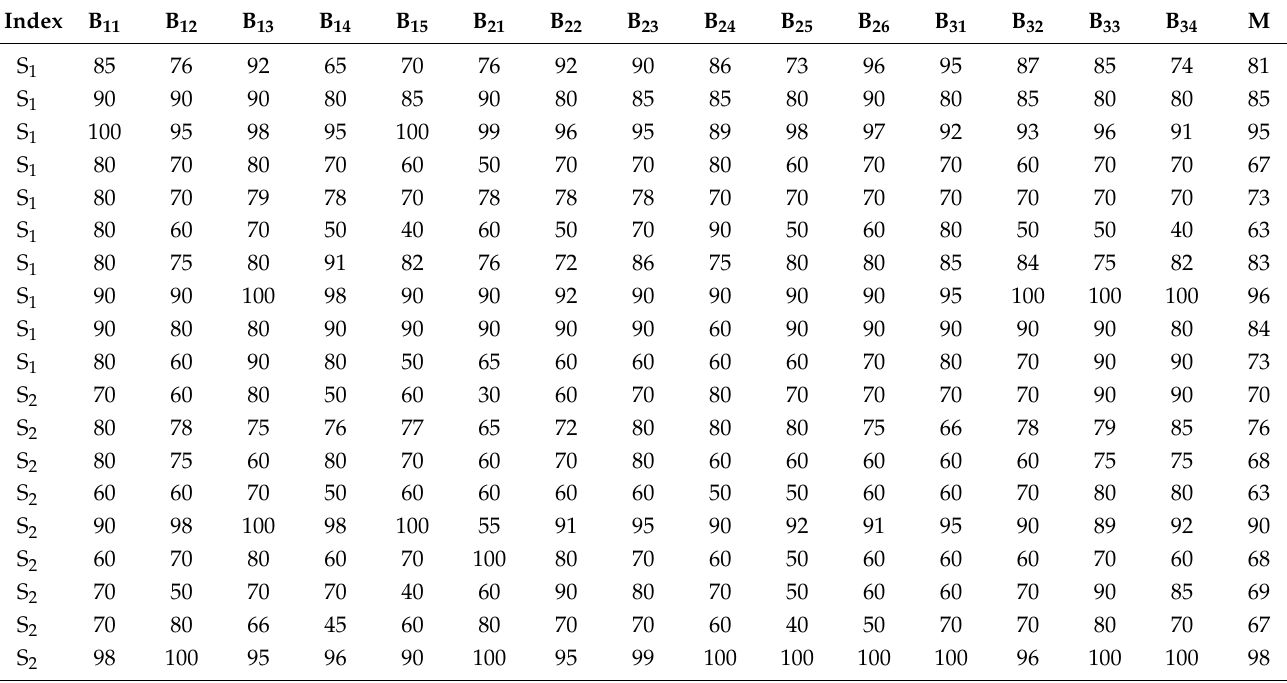
Table A1. BP neural network model training sample